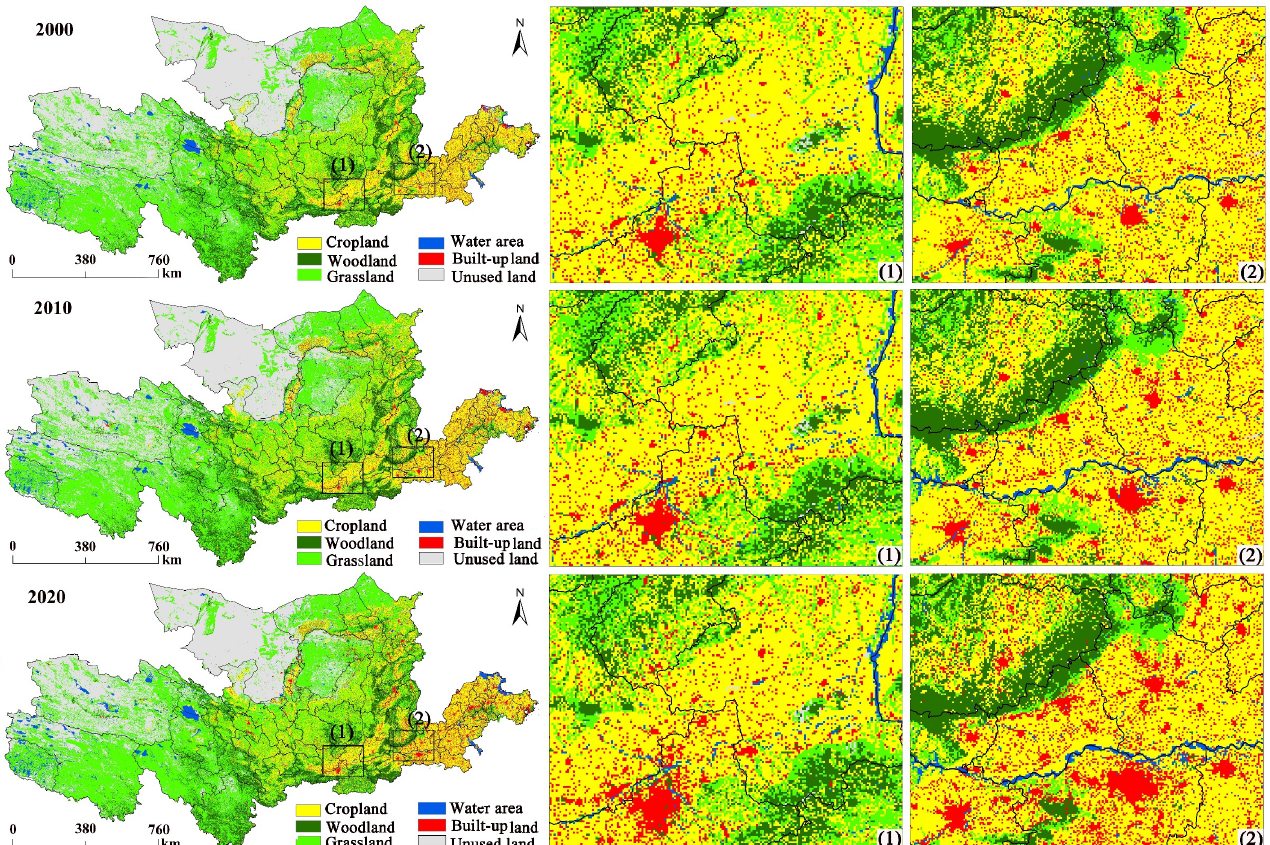
Figure 4. Spatial change of land use in the YRB between 2000 and 2020. (1) and (2) represent two randomly selected areas of significant change.